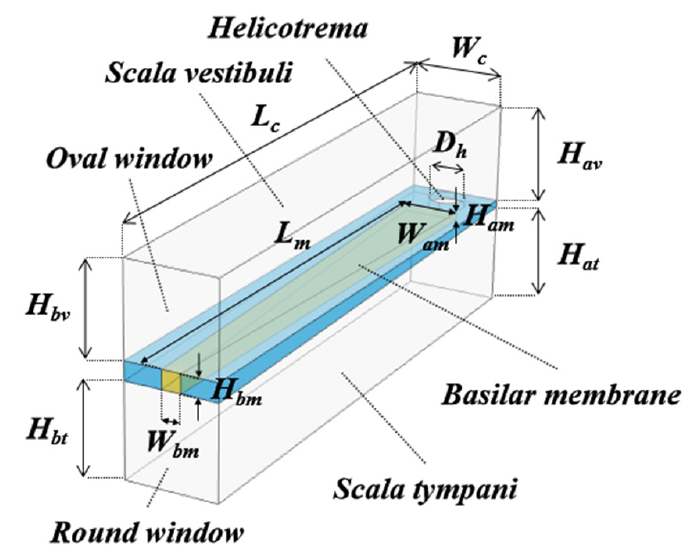
Figure 1. A straight–shaped cochlear model. The SV, ST and helicotrema are filled with a compressible perilymph. The fan–shaped BM is embedded in the SM. L c = 35 mm, W c = 1.2 mm, H bv = H bt = 1.235 mm, H av = H at = 1.245 mm, W bm = 100 µm, H bm = 30 µm, W am = 500 µm, and H am = 10 µm [17–